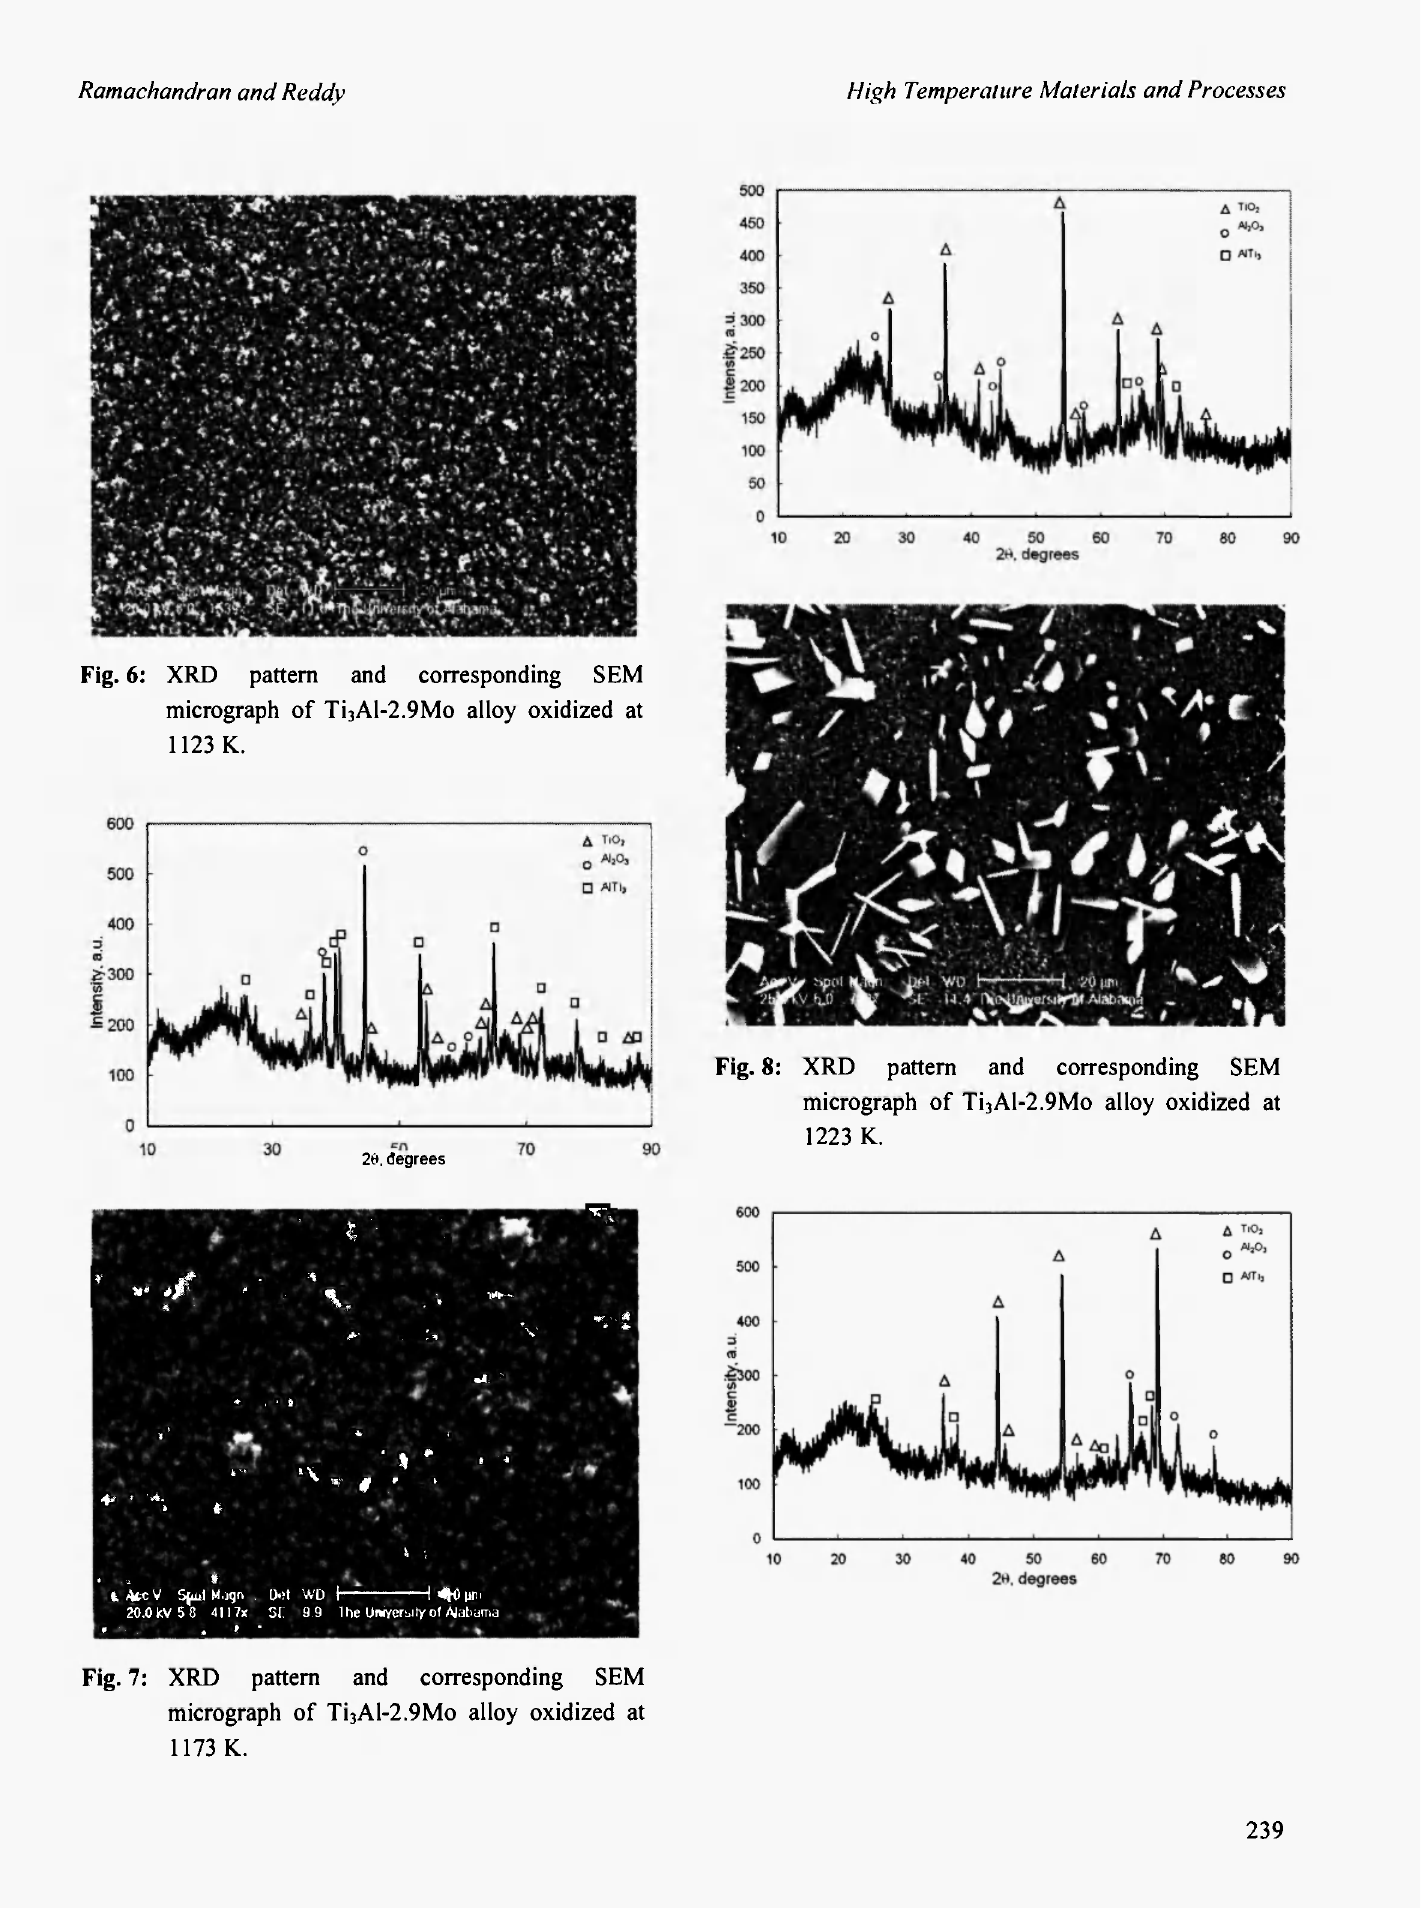
Fig. 7: XRD pattern and corresponding SEM micrograph of Ti 3 Al-2.9Mo alloy oxidized at 1173